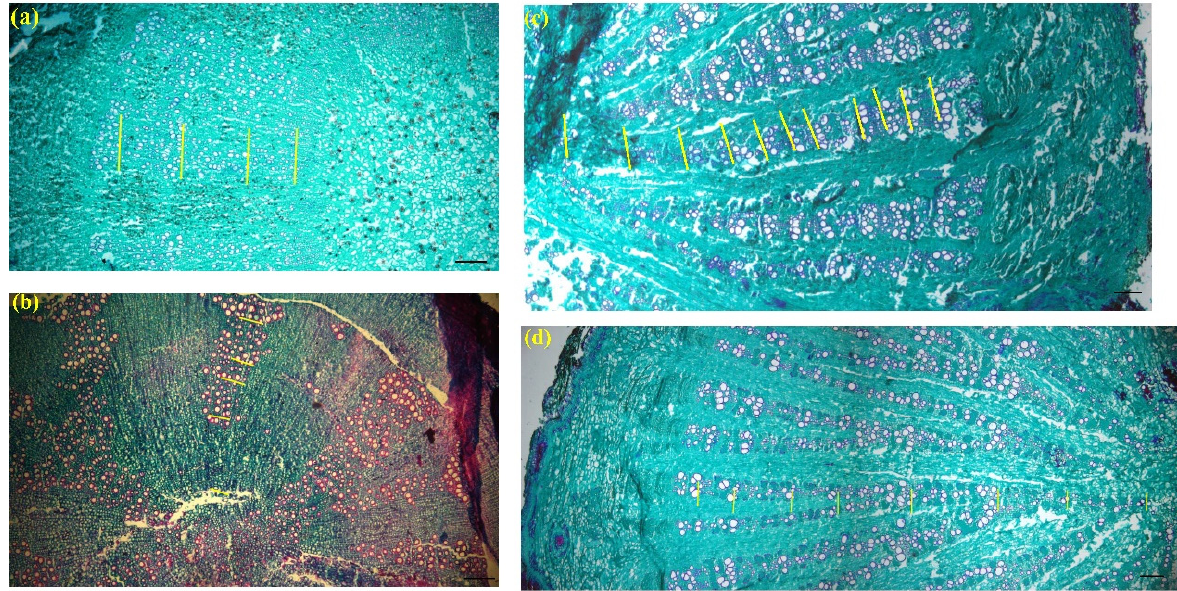
Figure 3. Root cross ‐ sections of perennial forbs. ( a ) Potentilla chinensis ; ( b ) Potentilla tanacetifolia ; ( c ) Medicago falcata ; ( d ) Medicago sativa . Yellow markers indicate annual ring boundaries. Scale bars = 200 μ m.